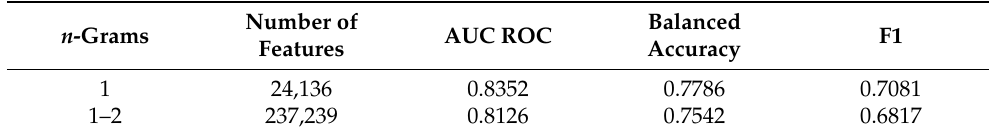
Table 6. The result of word classifications for the main data